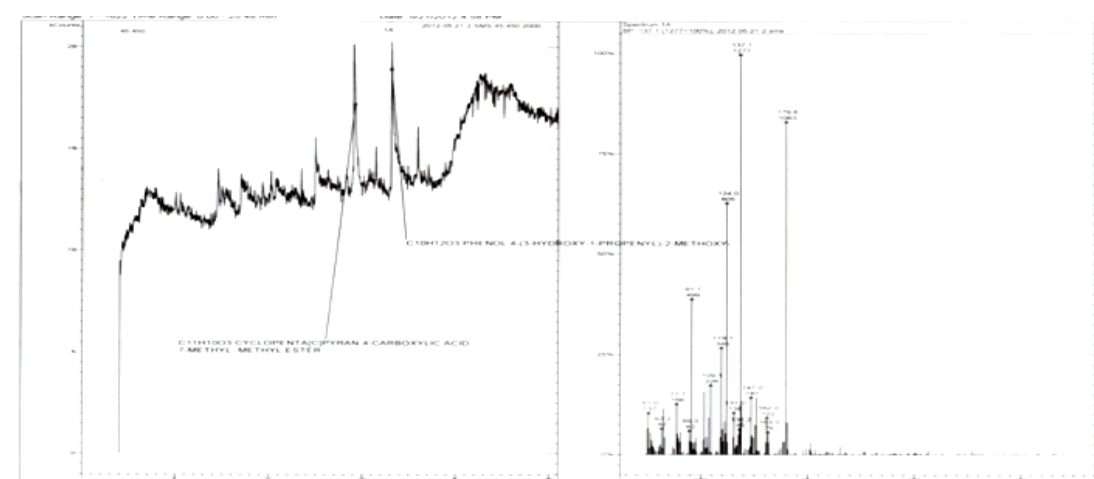
Fig. 1. MS spectrum of Phenol,